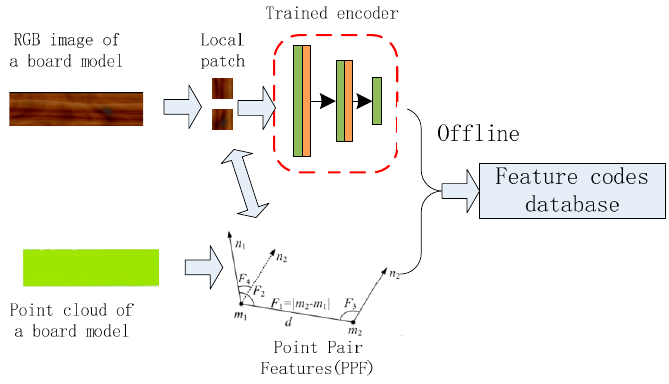
Figure 7. Establishment of feature code database of the wood plank model.